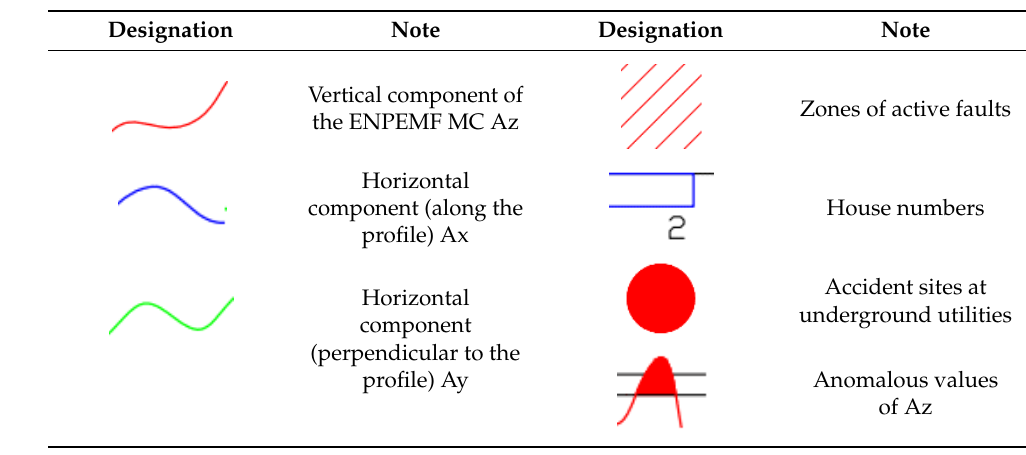
Figure 3. The results of the measurement of the ENPEMF MC along Glinka Street, Saint Peters- burg, Russian Federation. Designations, used in Figures 1–3, are given in Table 2.